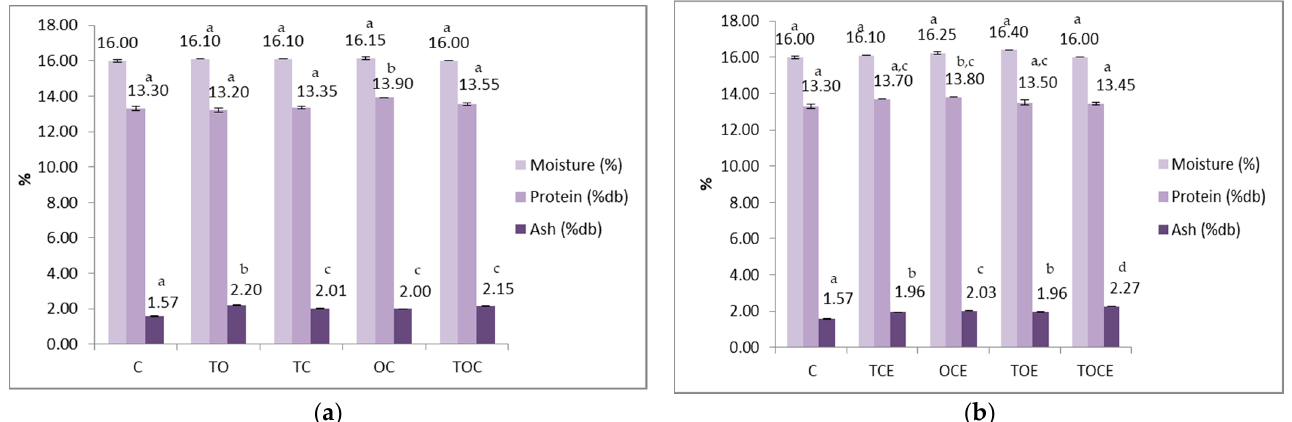
Figure 5 . Physical–chemical parameters of wheat seeds contaminated with DON, before and after treatment with: ( a ) binary and tertiary mixtures of EOs, and ( b ) binary and tertiary mixtures of natural emulsions. C—control; OC—binary mixture of oregano and coriander EOs; OCE—binary emulsion of oregano and coriander EOs; TO—binary mixture of thyme and oregano EOs; TOE—binary emulsion of thyme and oregano EOs; TC—binary mixture of thyme and coriander EOs; TCE—binary emulsion of thyme and coriander EOs; TOC—tertiary mixture of oregano, coriander, and thyme EOs; TOCE—tertiary emulsion of oregano, coriander, and thyme EOs. The values are expressed as mean values ± standard deviations of all measurements. Different superscripts a–d between samples for the same parameters represents significantly different values ( p < 0.05) according to the t -test; the same superscripts a–d between samples for the same parameters represents not significantly different values ( p > 0.05).